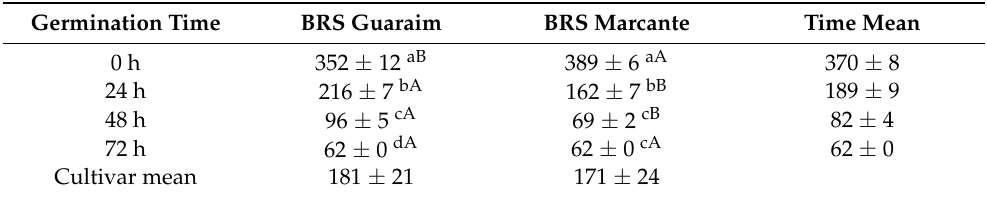
Table 1. Germination follow-up through grain falling number values (GFN, expressed in seconds) of wheat cultivars from soft (BRS Guaraim) and hard (BRS Marcante)